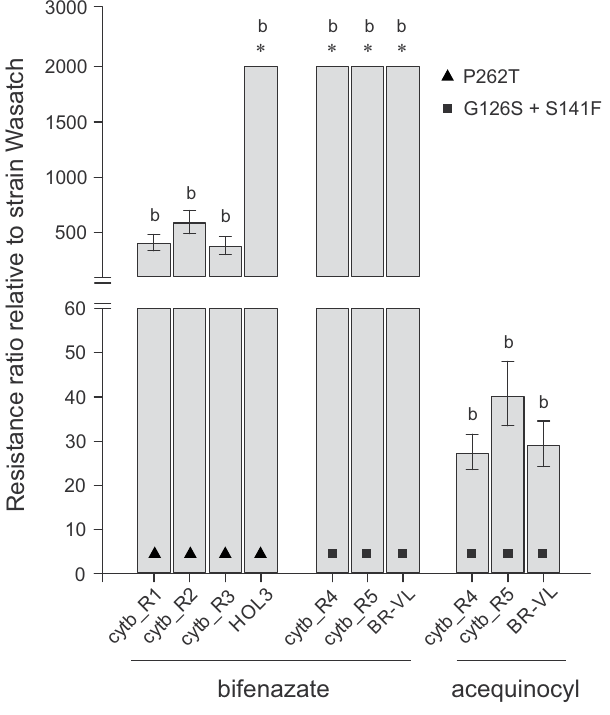
Figure 2. Susceptibility of backcrossed T. urticae lines cytb_R1-R3 (P262T) and cytb_R4, R5 (G126S + S141F) and the resistant parental strains HOL3 and BR-VL to QoI acaricides bifenazate and acequinocyl. The RRs were calculated as the LC 50 values of the backcrossed lines divided by the LC 50 of the parental susceptible strain Wasatch. Stars indicate strains for which the LC 50 value exceeded 5,000 mg l − 1 . Error bars represent 95% confidence limits calculated by probit analysis. Letters above bars indicate lines where acaricide treatment had statistically the same ( a ) or different ( b ) effect comparing to Wasatch (PoloPlus LeOra Software) 49